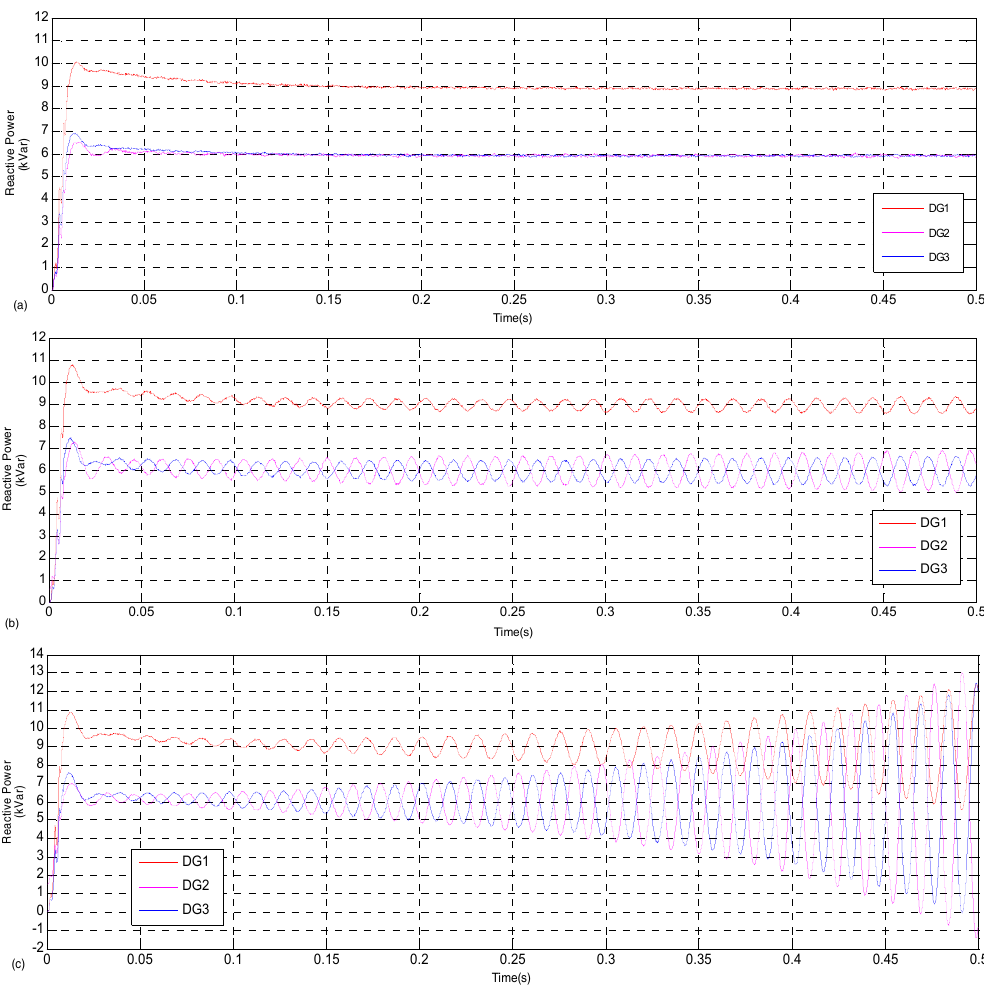
Figure 10. Simulation results in Case D: ( a ) reactive power with τ is 0.05ms; ( b ) reactive power with τ is 0.25ms; and ( c ) reactive power with τ is 0.5ms.